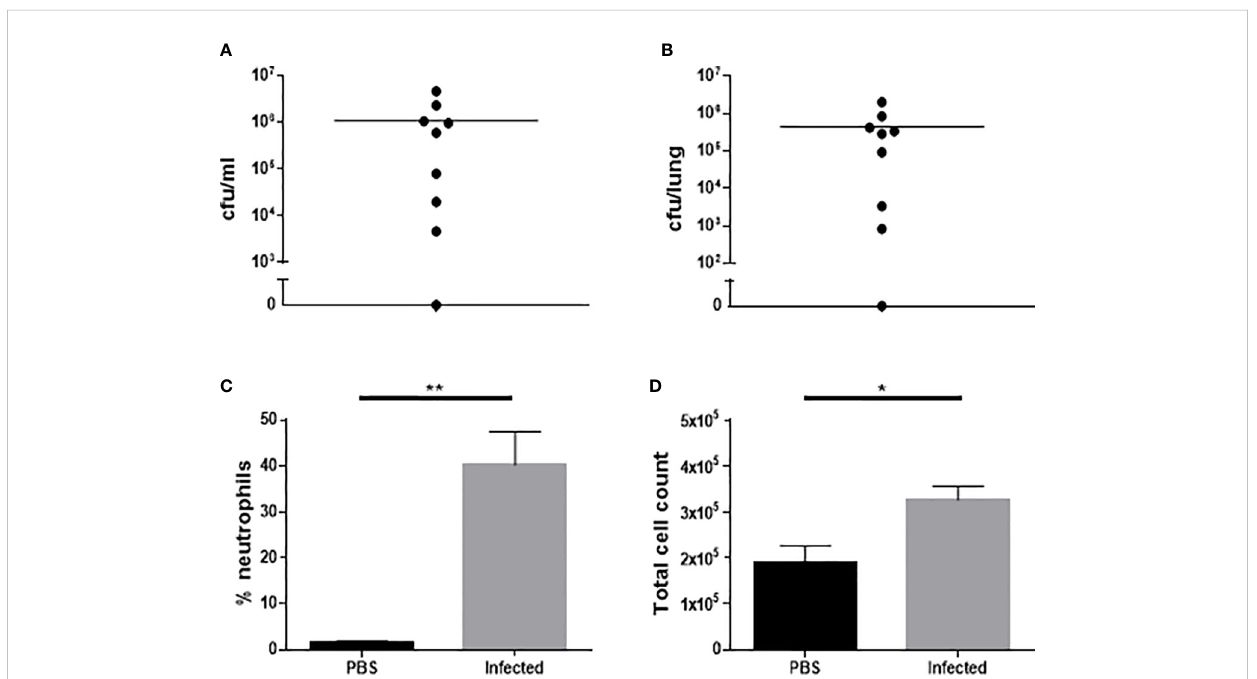
FIGURE 3 Characterization of microbiological and in fl ammatory features of Western diet-fed male ApoE -/- mice 24 hours after infection with 5 x10 5 cfu type 4 S. pneumoniae by intranasal instillation. Bacteria in blood (A) and lung homogenates (B) following infection with S. pneumoniae (n=9). Differential BAL fl uid cell count expressed as % neutrophils (C) following infection or mock infection with PBS (n=8-9, **p<0.005, unpaired t-test with Welch ’ s correction). Total BAL fl uid cell count (D) following infection or mock infection with PBS (n=8-9,